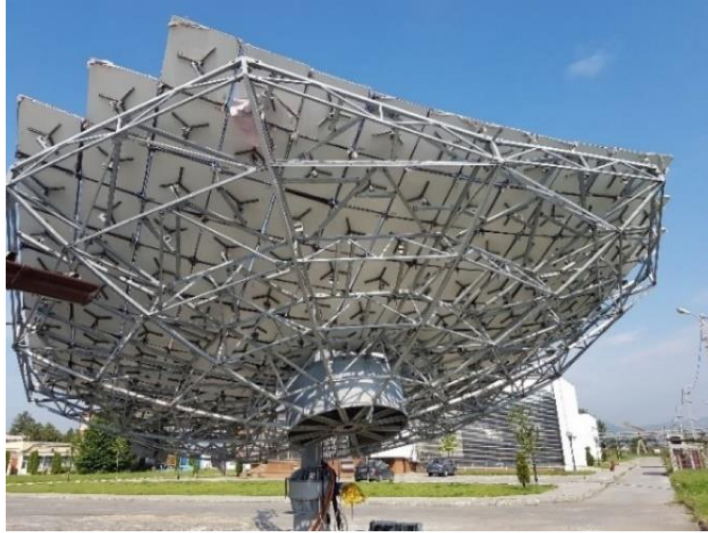
Figure 10. Installed solar concentrator in its working